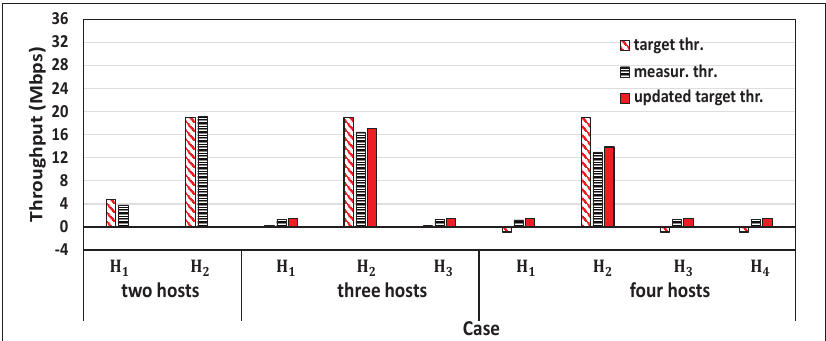
Figure 13. Results for Priority Host Scenario with proposal.